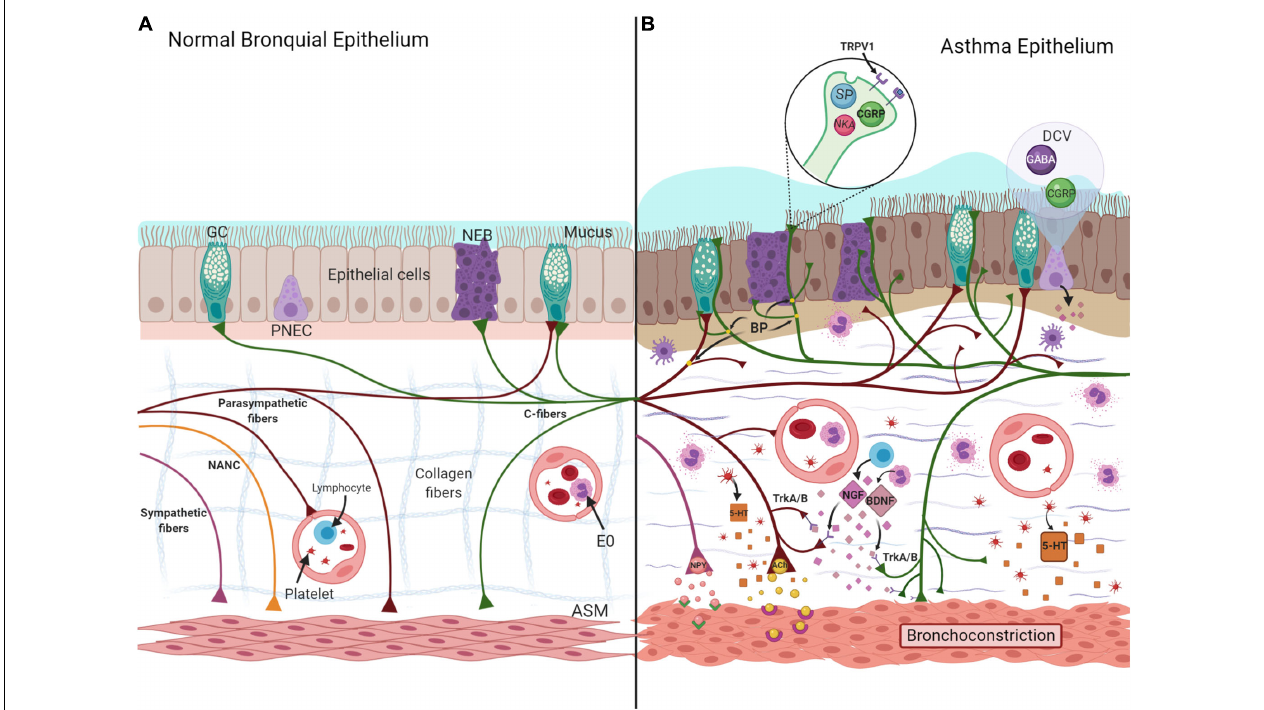
FIGURE 2 | Normal (A) and asthma-induced epithelial damage (B) . Neurotrophins (NGF- Nerve Growth Factor and BDNF-Brain-Derived Neurotrophic Factor) are synthesized by eosinophils (E0) and lymphocytes, the union to their receptor (TrkA/B), localized in nerves induce a greater length of nerves, increasing branch points (BP), and exposition of nerve endings to the lumen. NT and NP (SP, CGRP, NKA, ACh, 5-HT) are stored and released from these TRPV1 + fibers, increasing mucus secretion, collagenous deposition, and ASM hyperplasia, characteristic findings associated to asthma. Likewise, 5-HT and NPY increase the bronchoconstriction induced by ACh. ASM, airway smooth muscle; DVC, dense core vesicles; GC, Goblet cell; NANC, non-adrenergic/non-cholinergic; NEB, neuroepithelial bodies; PNEC, pulmonary neuroendocrine cell; TRPV1, transient receptor potential vanilloid